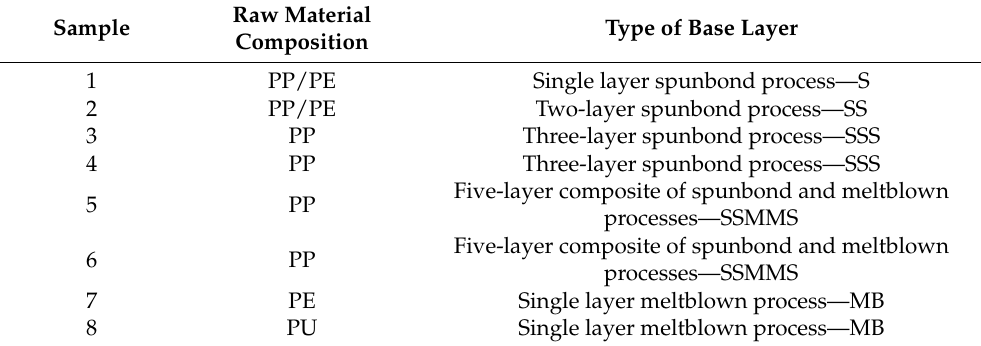
Table 1. Raw material composition and base layer production